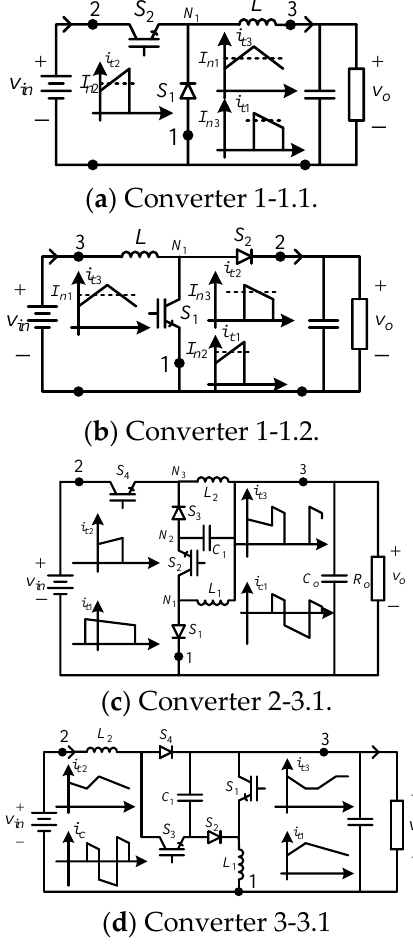
Figure 13. Examples of DC – DC converters from various converter cells .